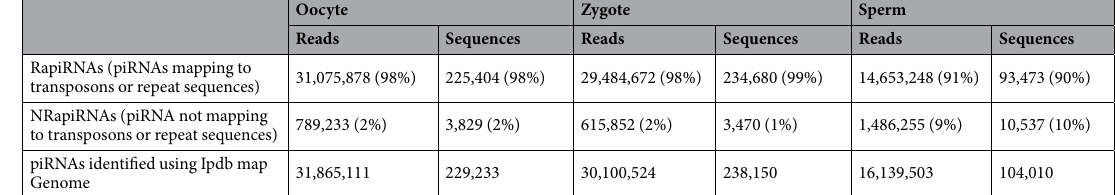
Table 2. Total number of sequences and reads of two piRNA populations classified according to their TE associations. Percentages in brackets were calculated in relation to total number of piRNAs identified using the piRNA IP database according to the RapiRNA and NRapiRNA populations.